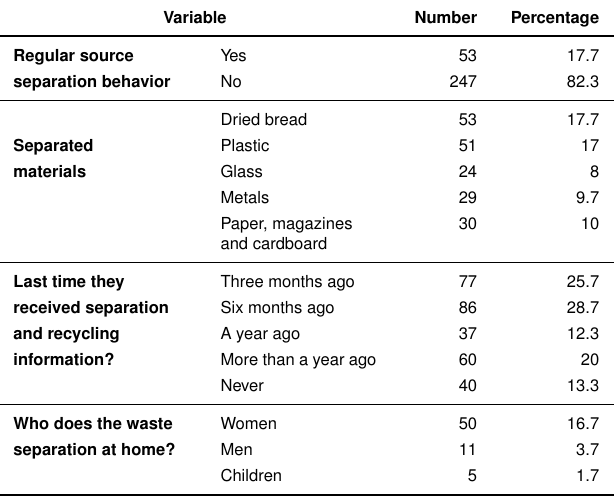
Table 4. The status of the study subjects on waste separa- tion